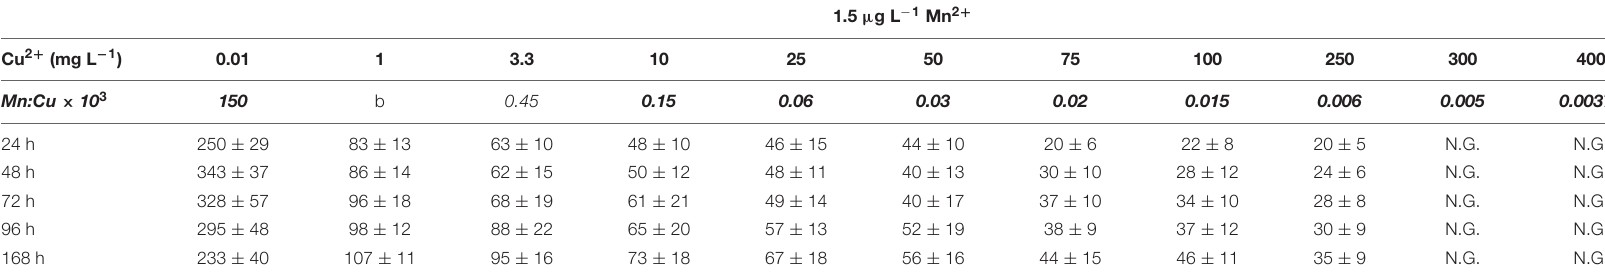
TABLE 4A | Average pellet size in A. terreus NRRL1960 D -glucose-grown cultures as a function of the copper(II) ion concentration in the culture broth at Mn(II) limitation and